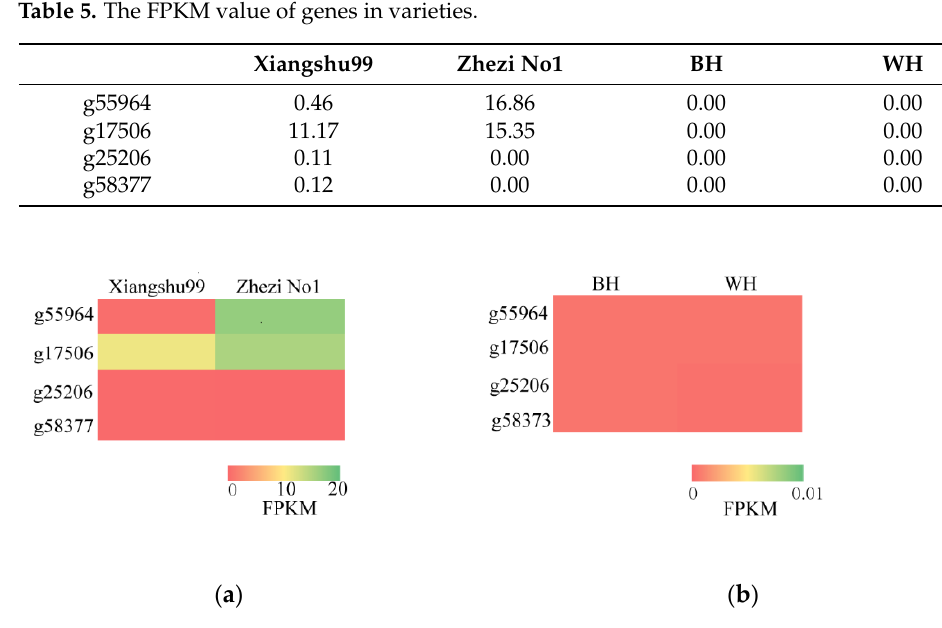
Figure 8. Heatmap of candidate genes in storage root by RNA-seq. ( a ) The expression of candidate genes in ‘Xiangshu99 ′ and ‘Zhezi No1 ′ (No. PRJNA721067); ( b ) The expression of candidate genes in ’BH’ and ‘WH’ (No. PRJDB10052).